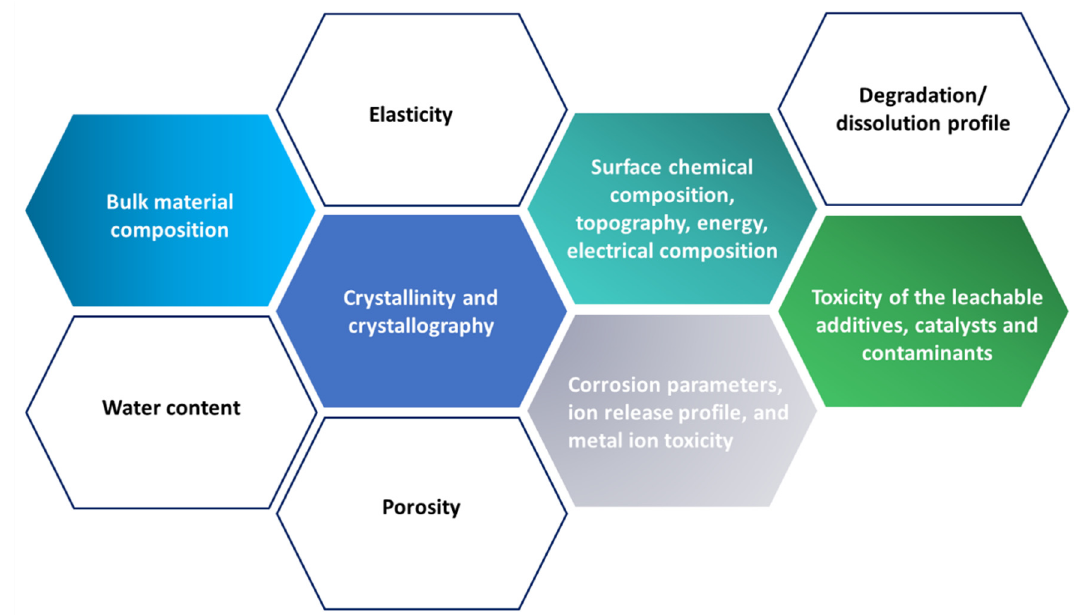
Figure 3. The essential variables that define the scaffold’s biocompatibility.